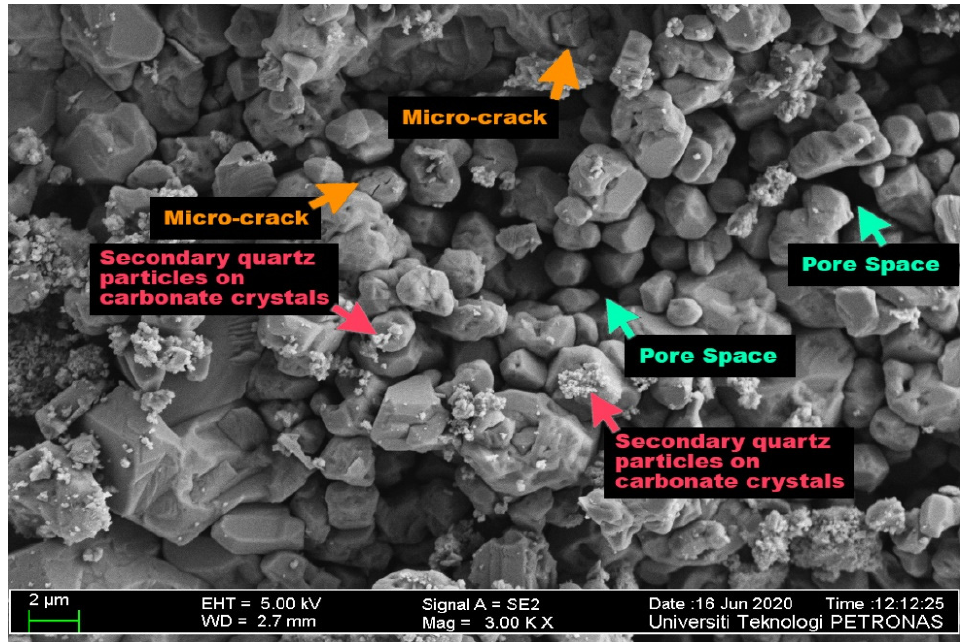
Figure 9. FESEM image of sample A-2.3 before permeability measurement.